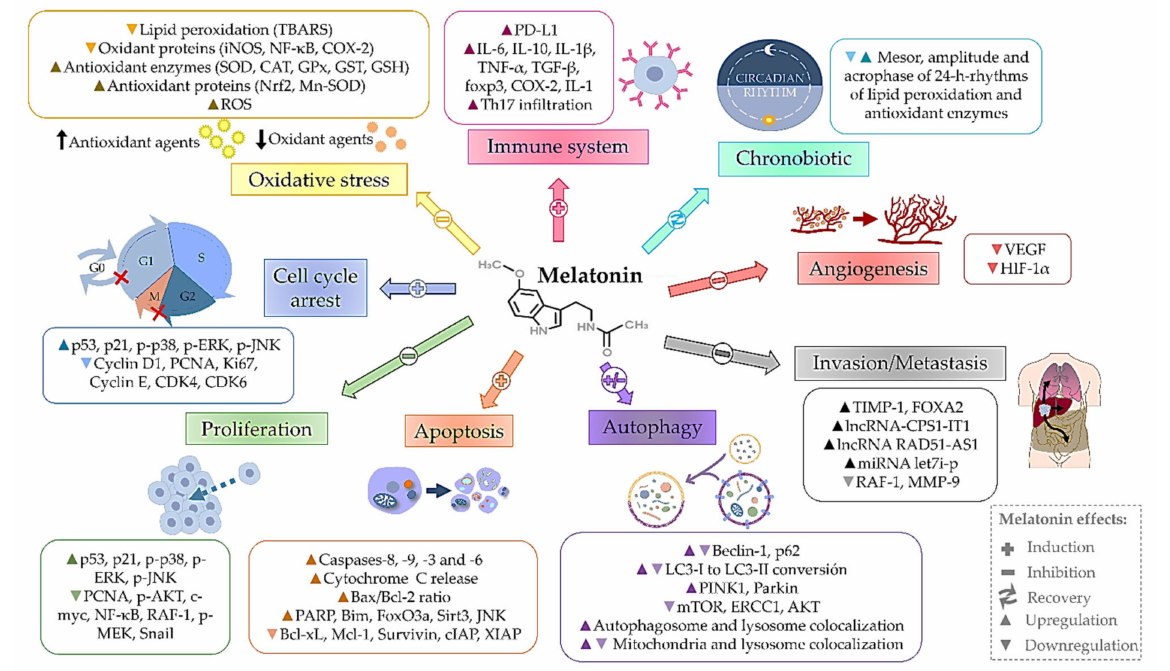
Figure 3. Cellular processes and protein expression modulated by melatonin in liver tumors. CAT, catalase; CDK, cyclin- dependent kinase; cIAP, cellular inhibitor apoptotic proteins; COX-2, cyclooxygenase-2; ERCC1, DNA excision repair cross complementary 1 protein; ERK, extracellular signal-regulated kinase; FOXA2, forkhead box A2; FoxO3a, forkhead box protein O3; foxp3, forkhead box P3; GPx, glutathione peroxidase; GSH, reduced glutathione; GST, glutathione S-transferase; HIF-1 α , hypoxia-inducible factor 1 α ; IL-1, interleukin-1; IL-1 β , interleukin 1 beta; IL-6, interleukin-6; IL-10, interleukin-10; iNOS, inducible nitric oxide synthase; JNK, c-Jun N-terminal kinase 1; LC3, microtubule-associated protein 1 light chain 3; lncRNA, long non-coding RNA; MEK, MAPK/ERK kinase 1; MMP-9, matrix metalloproteinase 9; Mn-SOD, manganese superoxide dismutase; mTOR, mammalian target of rapamycin; NF- κ B, nuclear factor-kappa B; Nrf2, nuclear erythroid 2-related factor 2; PARP, poly(ADP-ribose) polymerase; PCNA, proliferating cell nuclear antigen; PD-L1, programmed death ligand 1; PINK1, PTEN induced putative kinase 1; RAF-1, ras activated factor 1; ROS, reactive oxygen species; Sirt3, sirtuin 3; Snail, zinc finger protein SNAI1; SOD, superoxide dismutase; TBARS, thiobarbituric acid reactive substances; TGF- β , transforming growth factor β ; Th17, IL-17-producing T helper; TIMP-1, tissue inhibitor of metalloproteinases 1; TNF- α , tumor necrosis factor alpha; VEGF, vascular endothelial growth factor; XIAP, cellular and X-linked inhibitor apoptotic